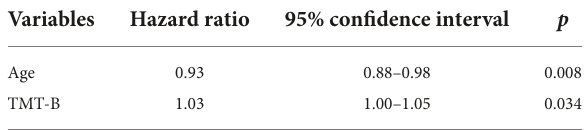
TABLE 6 The Cox proportional hazards model with likelihood ratio method (forward selection) for restoration group in work